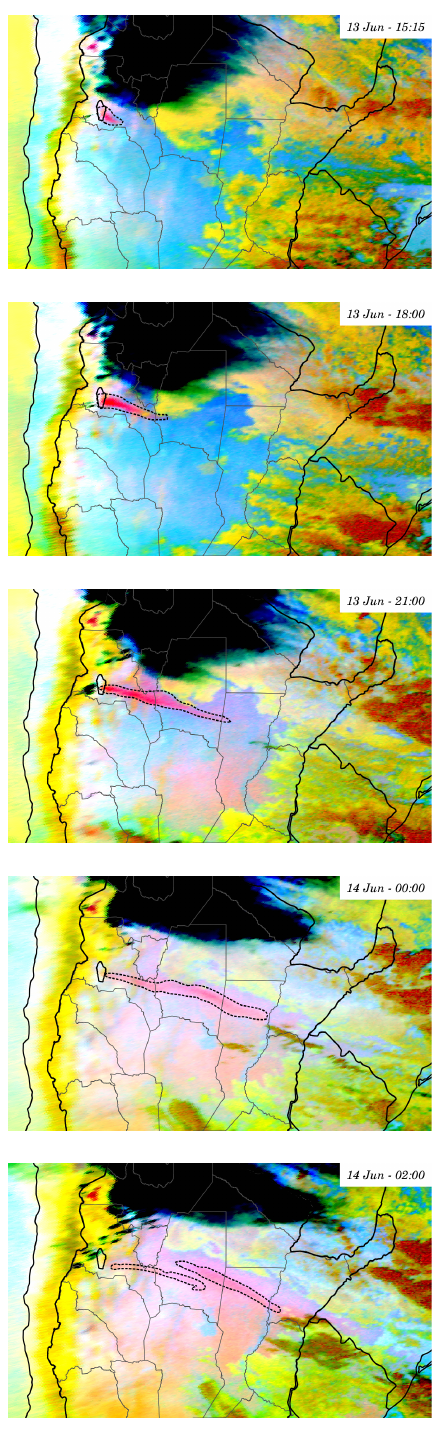
Figure 3. Dust detection with the MSG-SEVIRI RGB Product at 15:15, 18:00, 21:00 (13 June), 00:00, and 02:00 UTC (14 June). The dust cloud (black dashed line) moved southeastwards across northern Argentina. The dark spots on the top of the figures rep- resent meteorological clouds affecting parts of Argentina, Bolivia, Paraguay, and